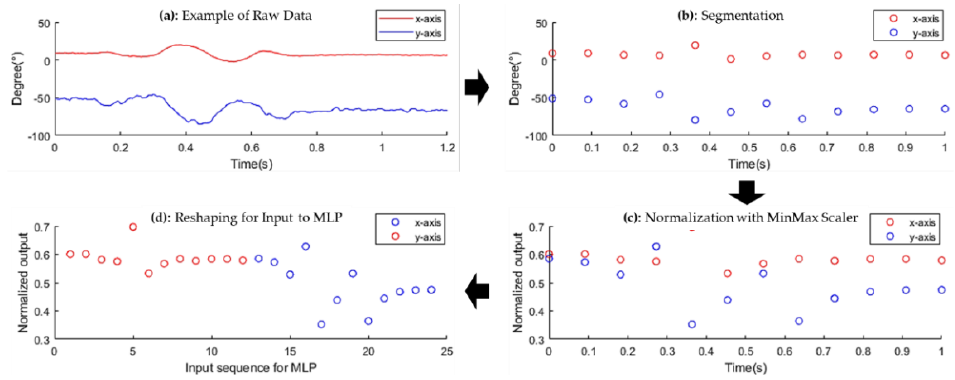
Figure 4. Preprocessing flow of the raw data collected.